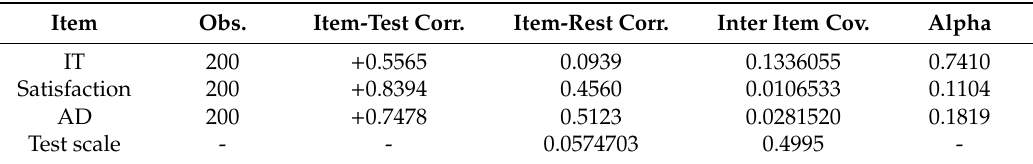
Table 4. Cronbach’s